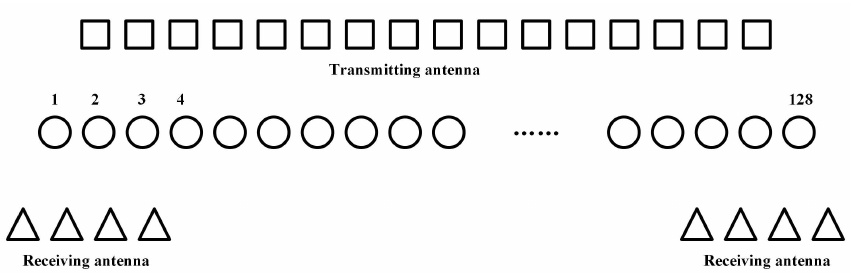
Figure 10. Equivalent observation channels